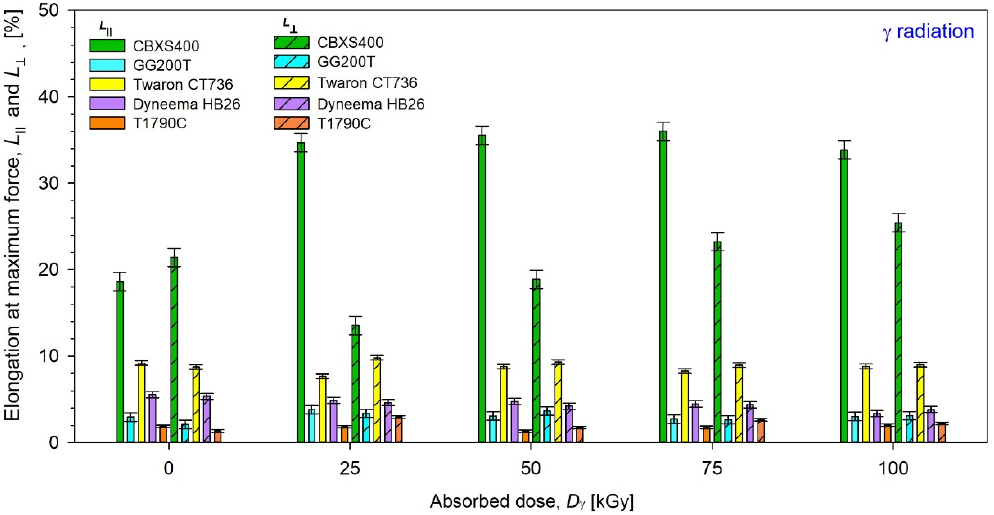
Figure 18. Elongation at maximum force of unmodified and γ-irradiated